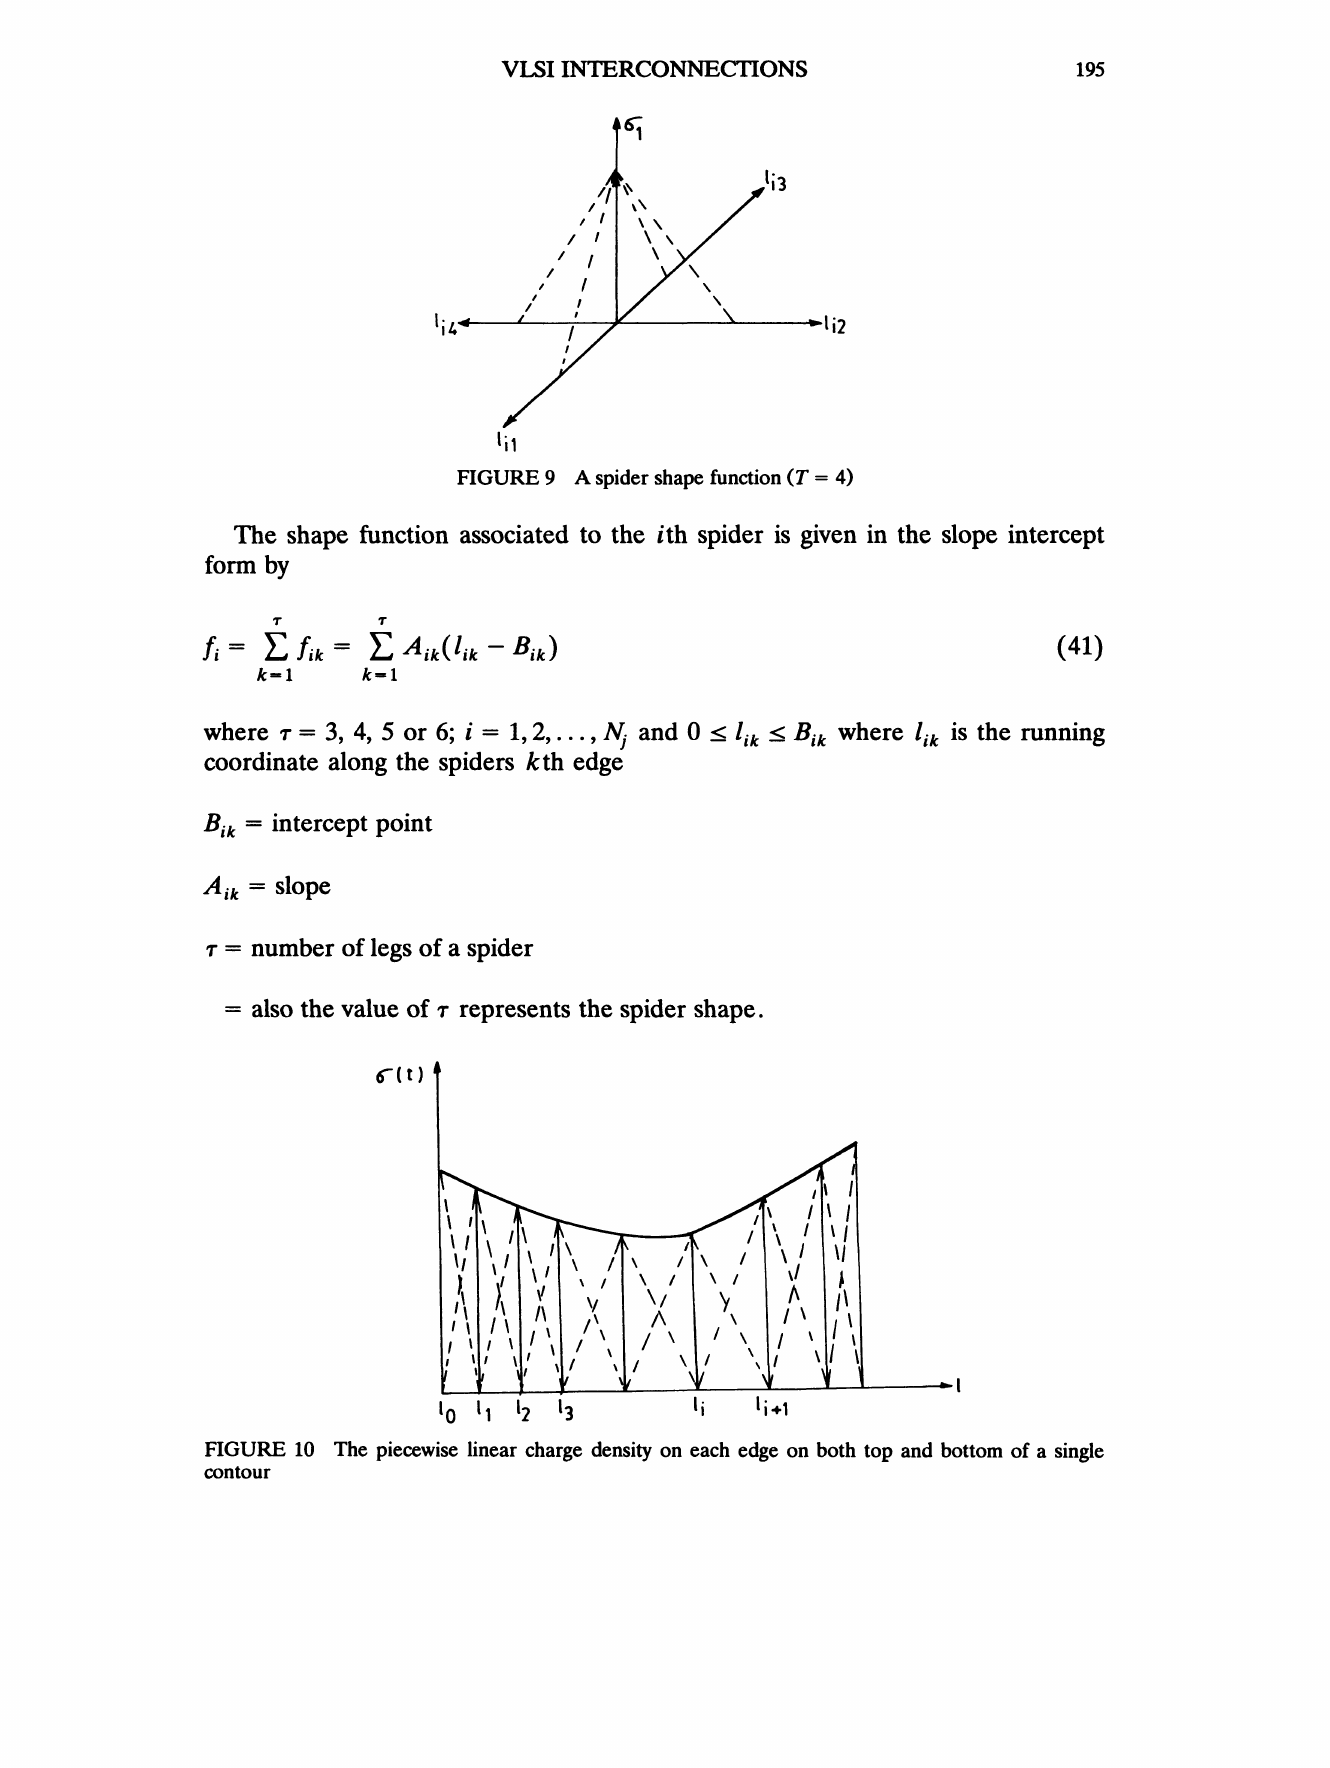
FIGURE 10 The piecewise linear charge density on each edge on both top and bottom of a single